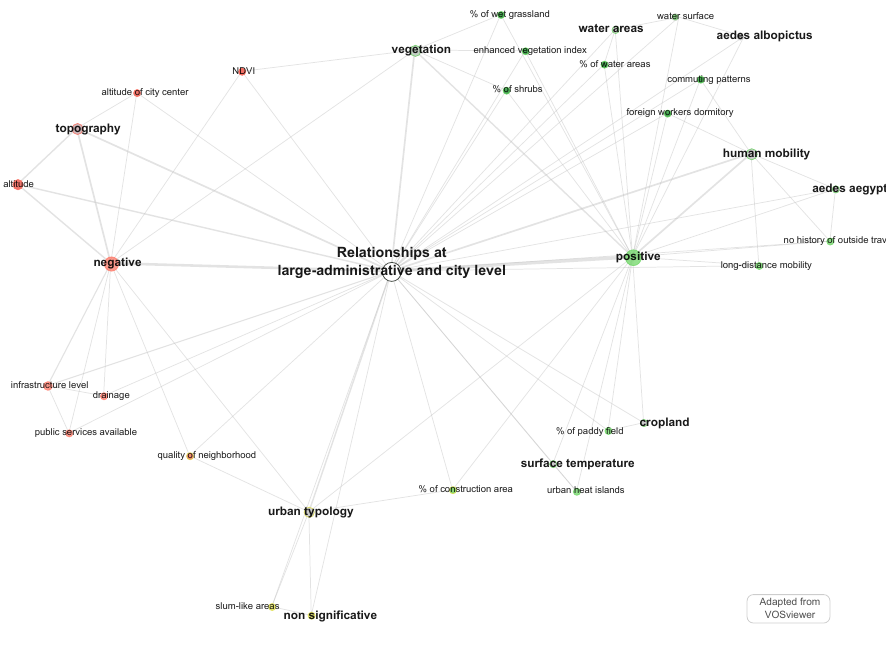
Figure 10. Co-occurrences network mapping of the self-defined keywords related to the landscape factors considered at large-administrative and